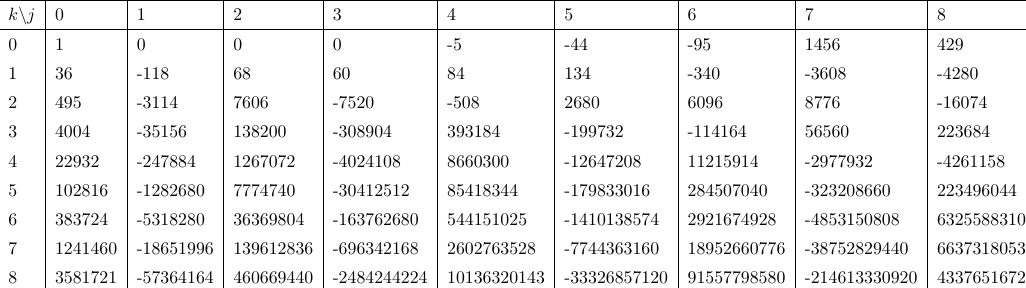
Table 58. Table of b jk coe(cid:14)cients for h SO(9)